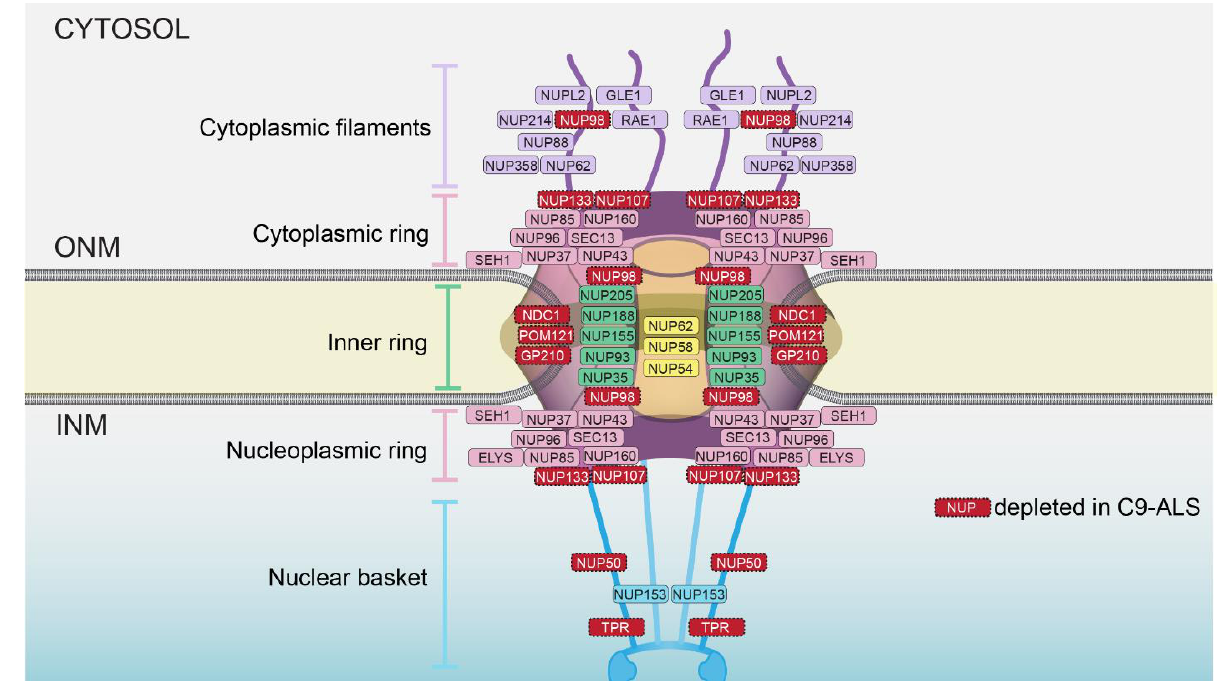
Figure 1. Schematic of NPC embedded in the nuclear envelope. Major architectural assemblies and relative position of individual nups are indicated. Nups, in red, are depleted in C9-ALS. ONM is outer nuclear membrane; INM is inner nuclear